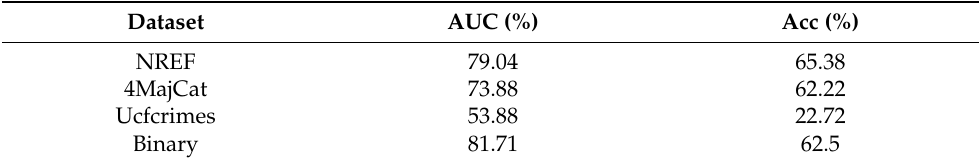
Table 8. Accuracy and AUC for all four datasets